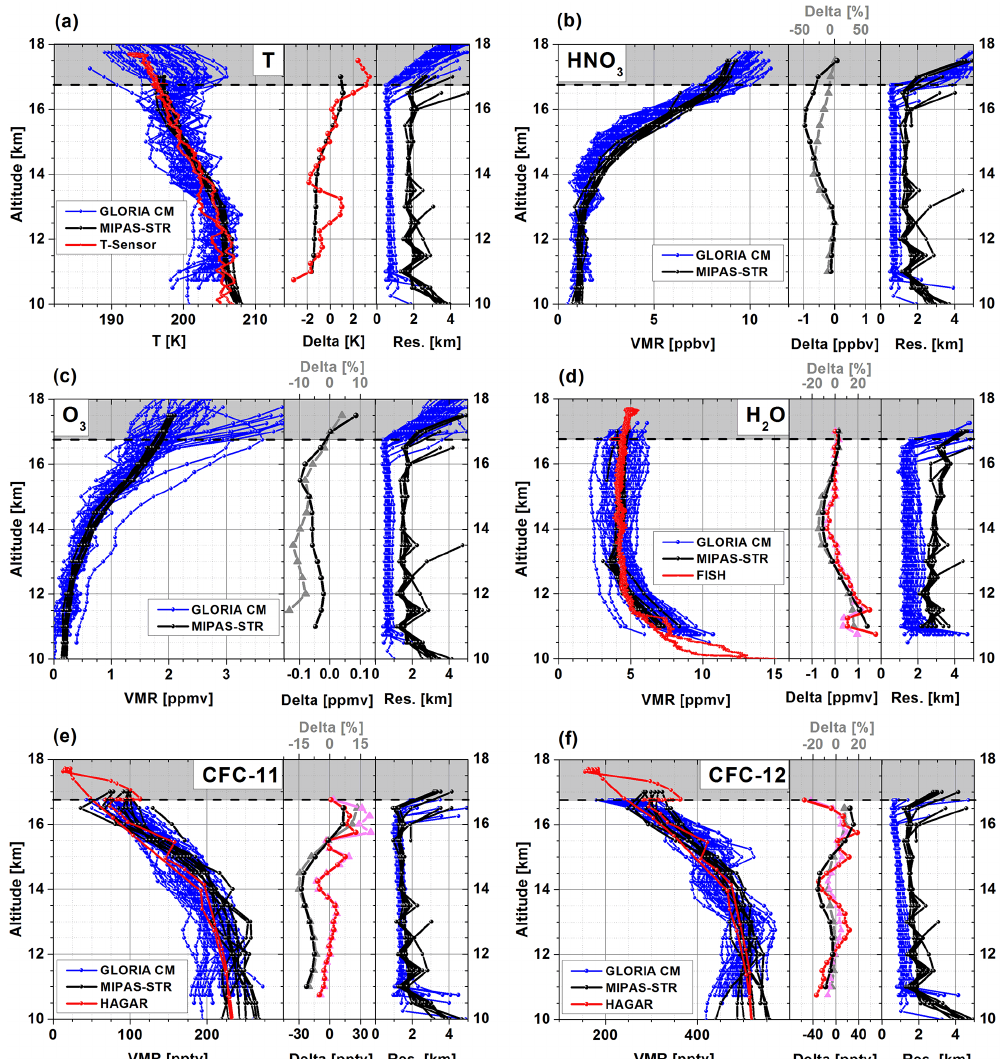
Figure 3. Comparison of retrieval results from GLORIA with MIPAS-STR and collocated in situ observations. Left panels: retrieved vertical profiles of indicated parameters from GLORIA (blue) and MIPAS-STR (black) together with available in situ profiles (red). Middle panels: absolute (black) and relative (grey) residuals between the mean profiles of GLORIA and MIPAS-STR as well as absolute (red) and relative (pink) residuals between mean profiles of GLORIA and the in situ observations. Right panels: vertical resolutions of the GLORIA (blue) and MIPAS-STR (black) profiles. Dashed horizontal black lines in all panels: approximate flight altitude during the GLORIA